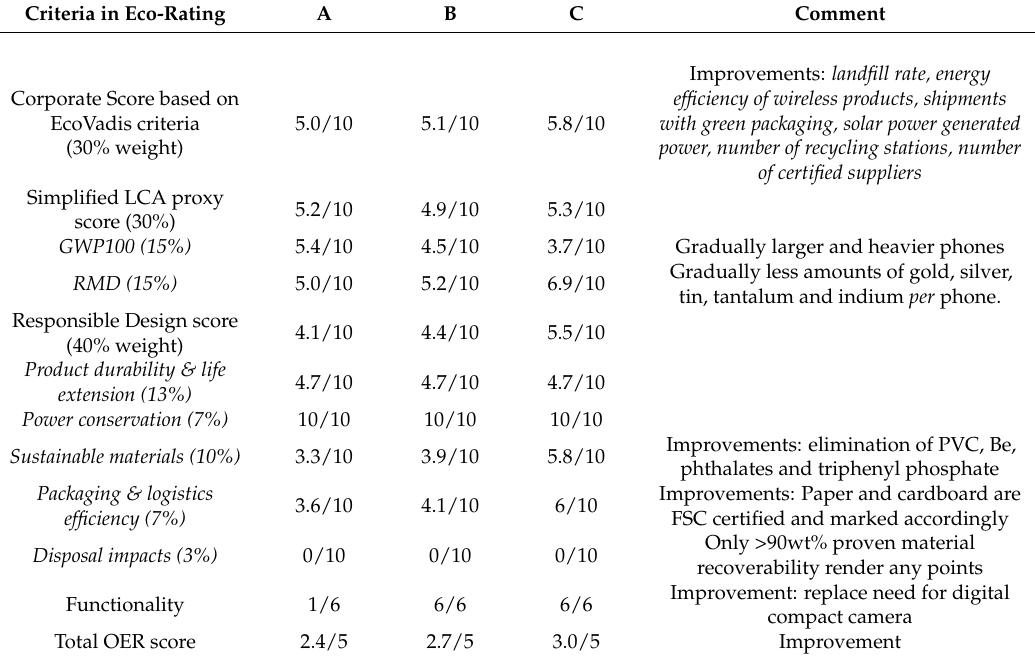
Table 4. Evolution of OER criteria (normalized scores) for smartphone models A, B, and C.